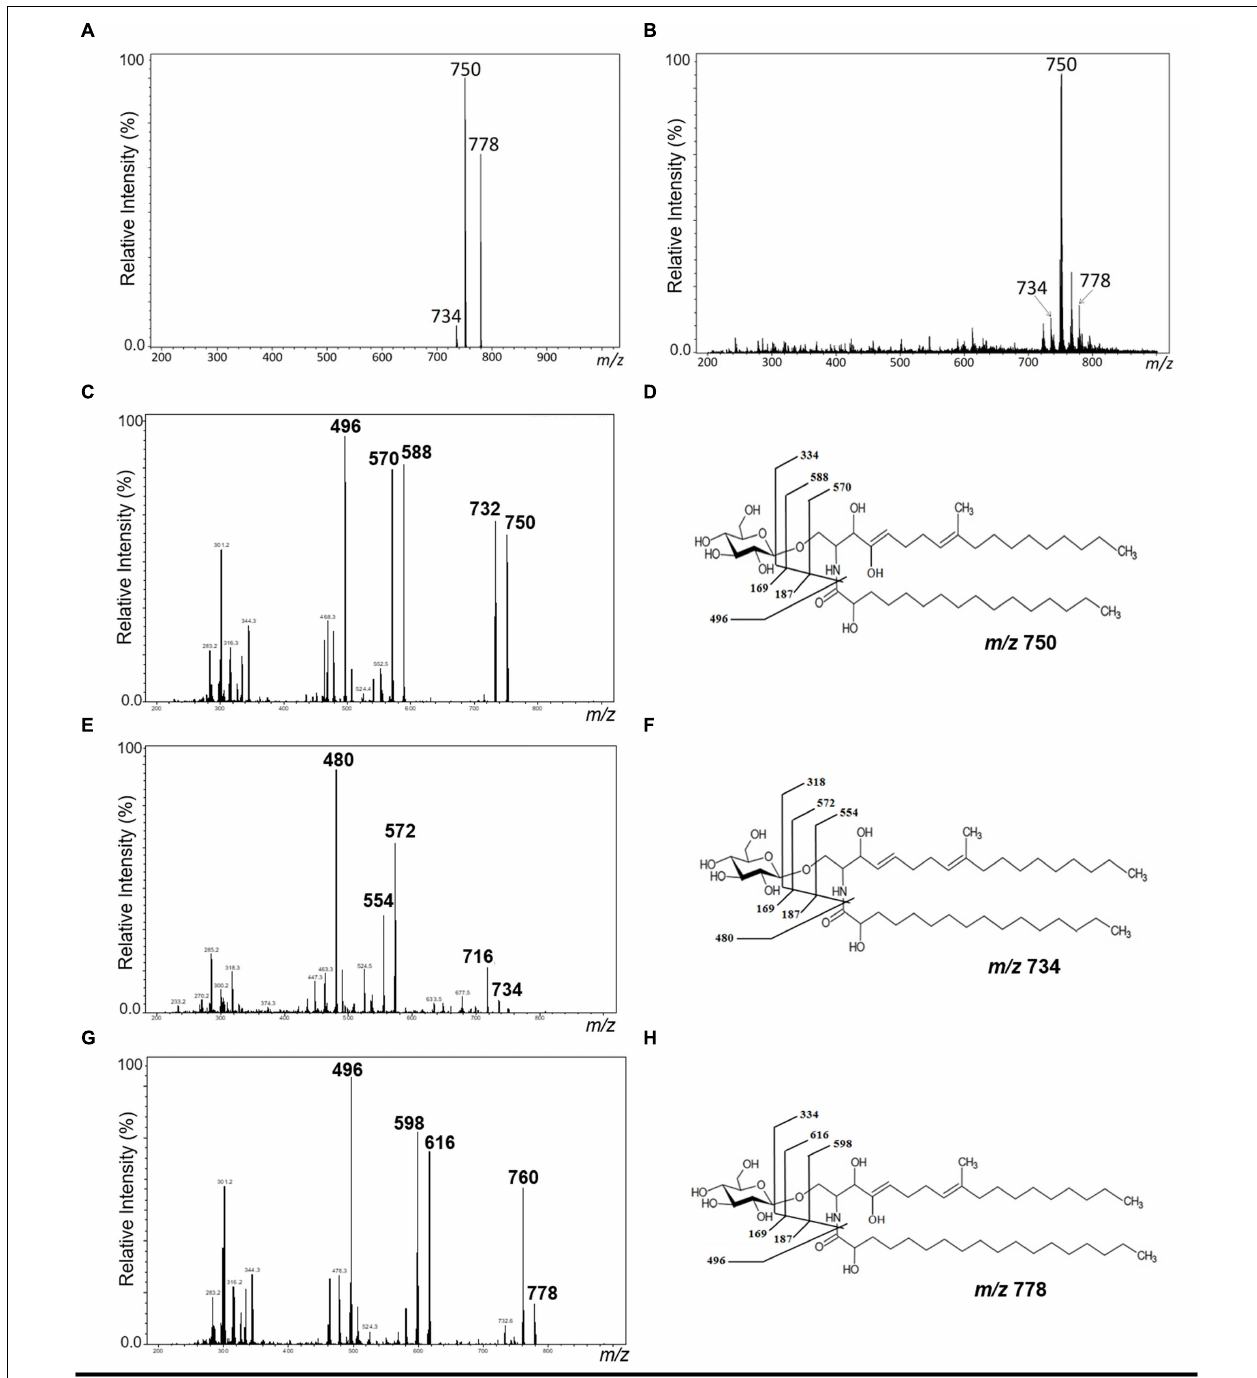
FIGURE 1 | Positive ESI-MS [M+Li] analysis of GlcCer species from L. prolificans . ESI-MS1 of GlcCer species from mycelial (A) and conidial (B) forms. ESI-MS2 of the ions species m/z 750, m/z 734, and m/z 778 (C , E,G) and proposed structures for each GlcCer species (D , F,H) from mycelial